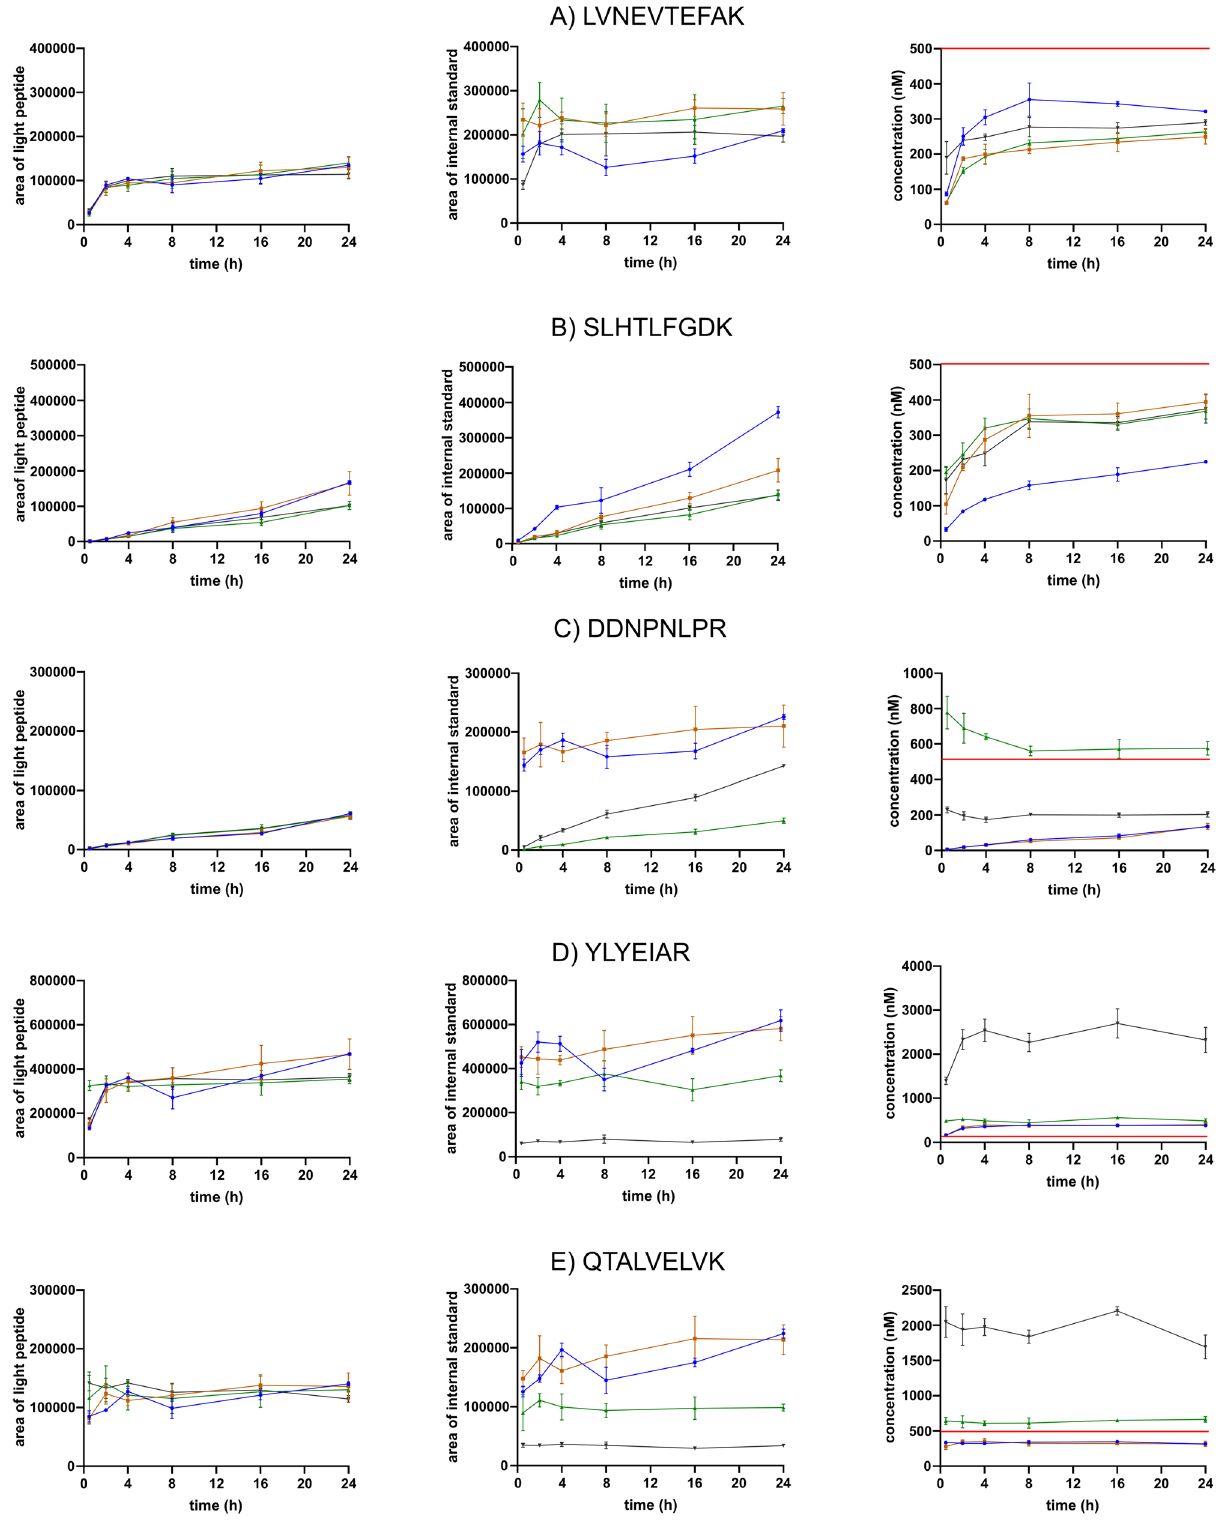
Figure 4. The trypsin digestion kinetics of signature peptides, LVNEVTEFAK ( A ), SLHTLFGDK ( B ), DDNPNLPR ( C ), YLYEIAR ( D ), and QTALVELVK ( E ). SIL-Ex peptide versions are color-coded: SIL-TCT (blue), SIL-ExC5 (orange), SIL-ExC3N3 (green), and SIL-ExC5N5 (black). For each signature peptide, the signal of light serum peptide (left panel) and SIL-Ex peptide (middle panel) is shown together with determined HSA concentration over digestion time (right panel). HSA concentration determined by reference methods (500 nM) indicated as a red